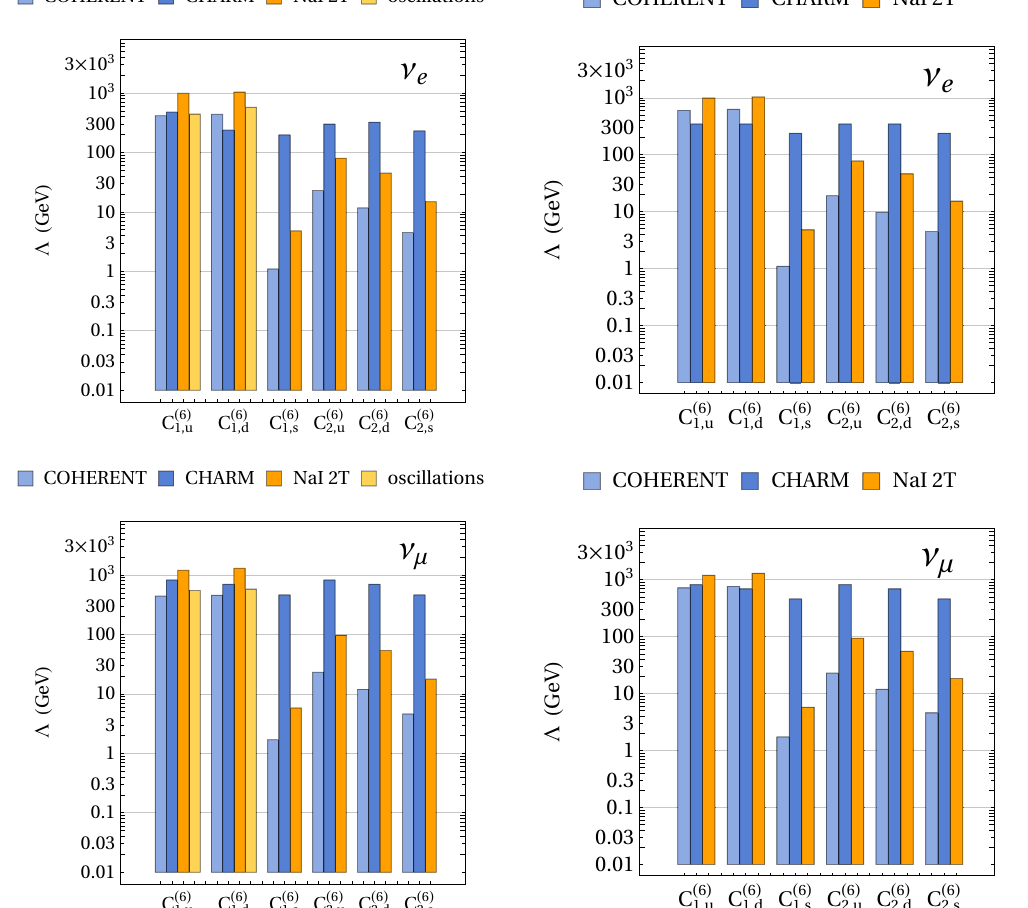
Figure 7 . Limits from COHERENT, CHARM, neutrino oscillations and projected limits from a NaI 2T experiment on the scale Λ of dimension 6 operators for electron neutrinos (top) and muon neutrinos (bottom). The two panels on the left correspond to lepton flavor conserving operators ( ν ), the ones on the right to lepton flavor violating operators ( ν i → ν i